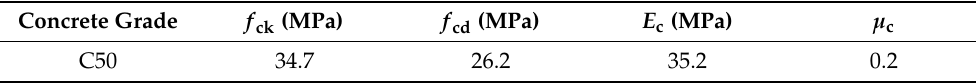
Table 3. Mechanical properties of